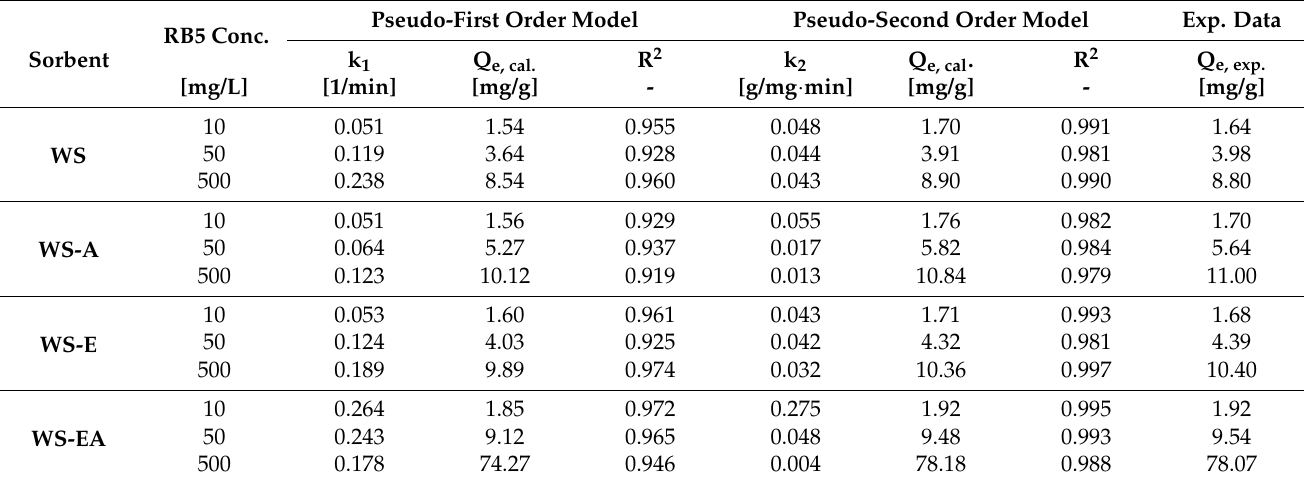
Table 3. Kinetic parameters of RB5 sorption onto WS, WS-E, WS-A, and WS-EA determined from the pseudo-first order and pseudo-second order